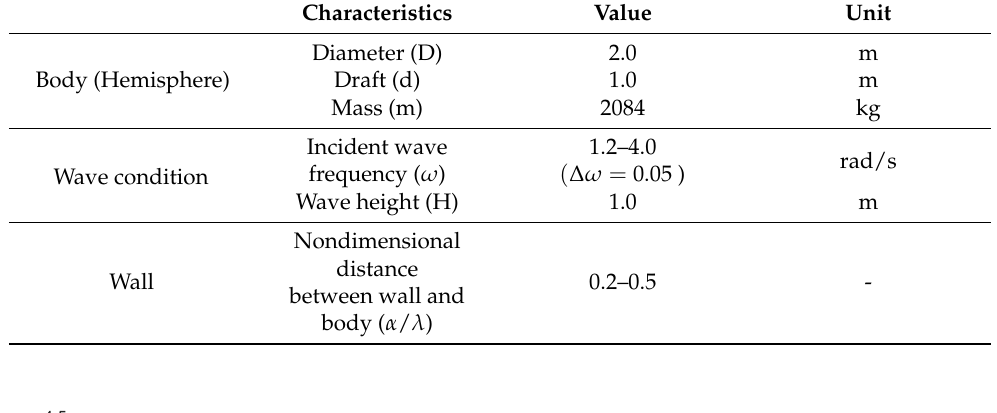
Figure 15. Comparison of the heave RAO of a cylindrical WEC with and without a breakwater. Table 3. Analysis conditions of a WEC integrated with a breakwater.